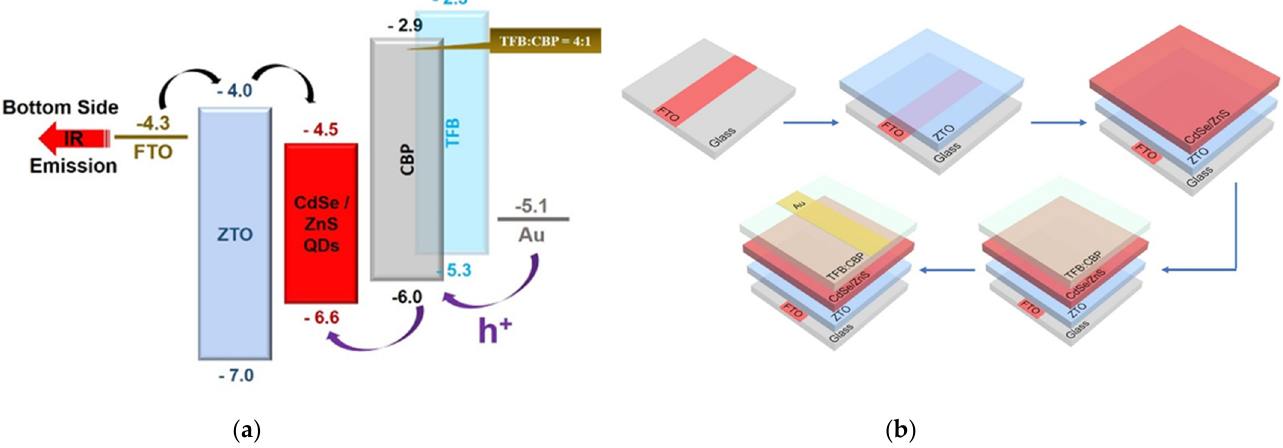
Figure 4. ( a ) Energy - level diagram of QD-based LED; ( b ) Schematic presentation of the fabrication of QD-LED. The current density–voltage (J–V) characteristics of the QD-LED are shown in Figure 5a. QD-LED inverted structure with good efficiency was obtained with ZTO based ETL of the designed device as compared to the reference device. Reduced J of QD-LED devices through ZTO indicates better charge carrier injection from the ETL to the CdSe/ZnS QDs. Figure 5b demonstrates that the ZTO-based LED has a slightly higher luminance than